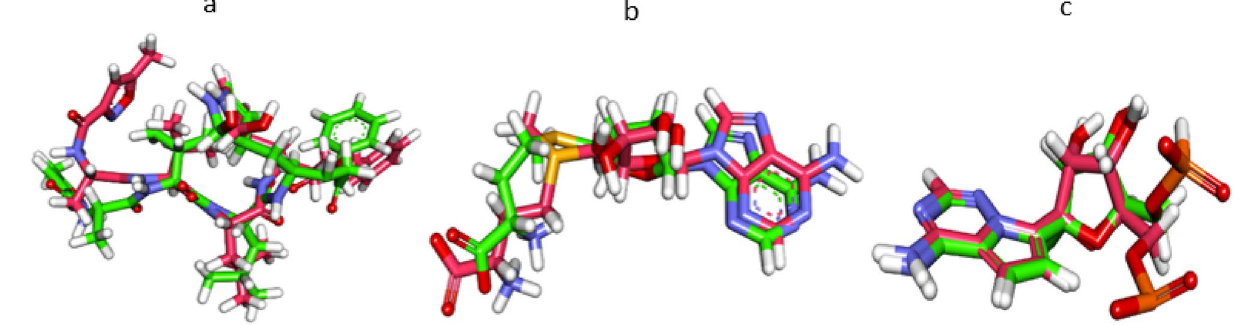
Figure 2. Superimposition of the co-crystallized pose and the docking pose of the same ligands. ( a ) PRD_002214 of COVID-19 main protease, ( b ) SAM of NSP10, ( c ) F86 of RNA-dependent RNA polymerase.